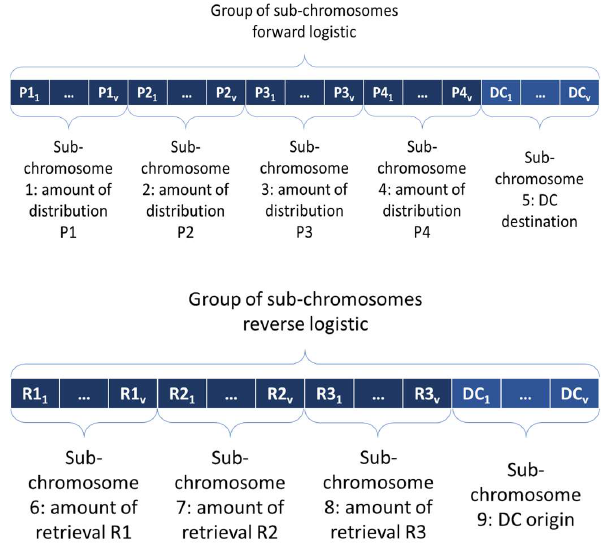
Fig. 2. Example of chromosome representation with 4 products and 3 retrieved